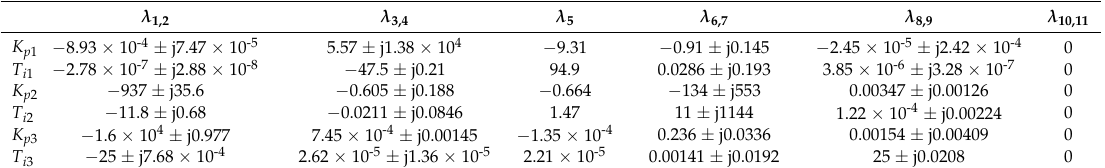
Table 3. Eigenvalue sensitivities.